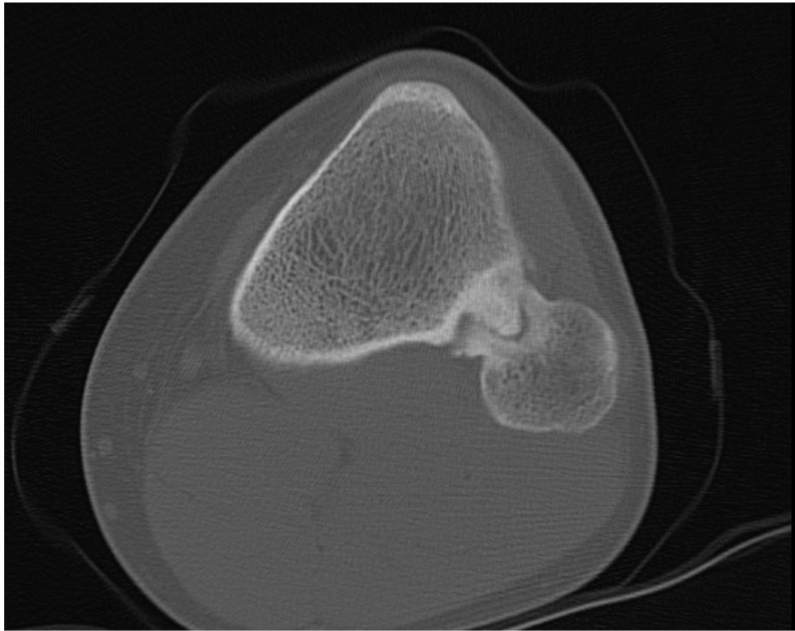
Figure 2. CT scan in horizontal view showing the synostosis of the left side. The MRI scan without contrast showed no thickened cartilaginous cap (Figure 3). The lesions were suspicious for bilateral osteochondroma of the proximal tibiofibular joint and showed no signs of